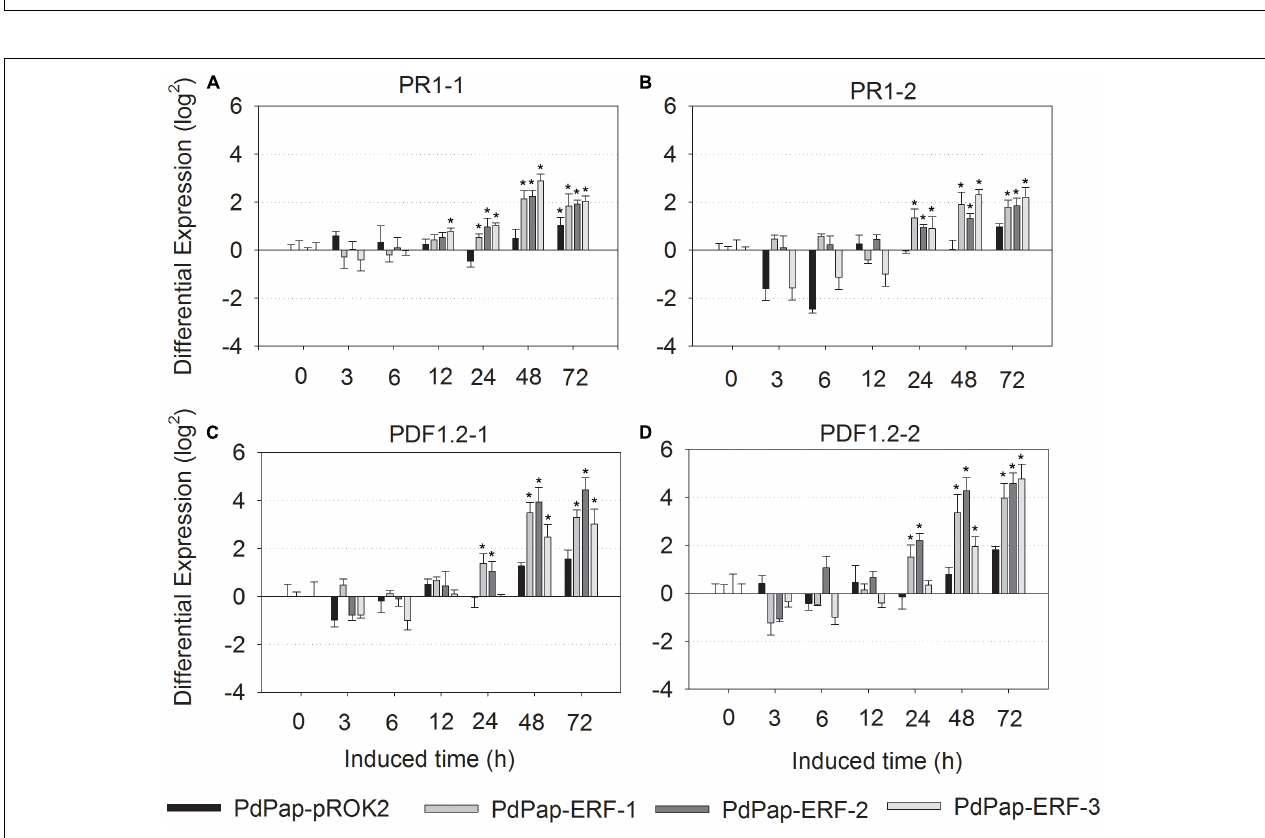
FIGURE 6 | The resistance of PdPap-MsERF105s to Aal. (A) The lesion on PdPap-MsERF105s and PdPap-ROK2 after being infected by Aal. (B) The cell membrane integrity of PdPap-MsERF105s and PdPap-ROK2 after being infected by Aal. ANOVA was conducted using Duncan’s method, and p ≤ 0.05 was considered significant.